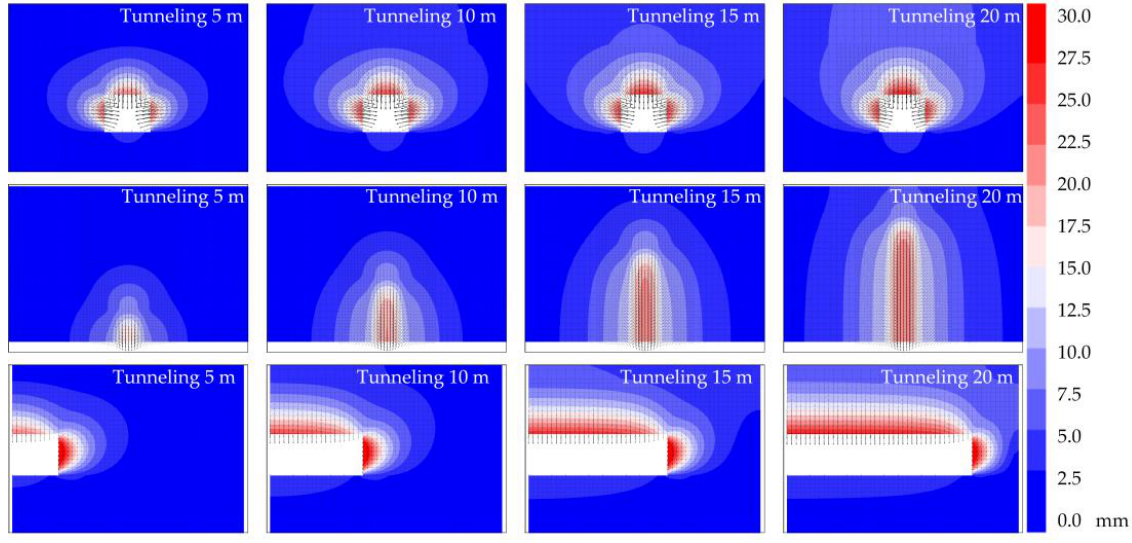
Figure 7. Displacement distribution characteristics of heading face.